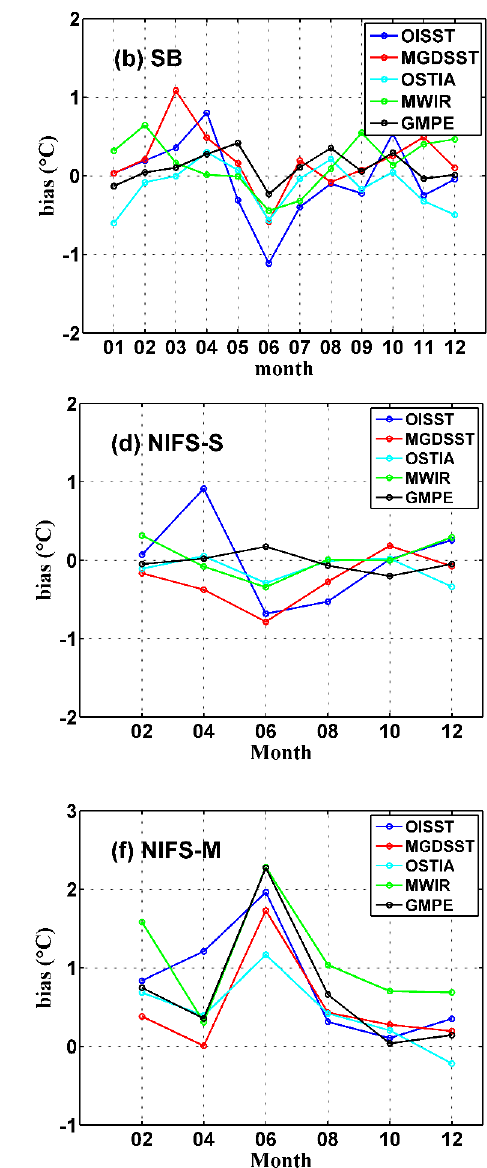
11 of 25 Figure 5. Seasonal variations in the monthly mean RMSD (°C) between the in situ SST and the global